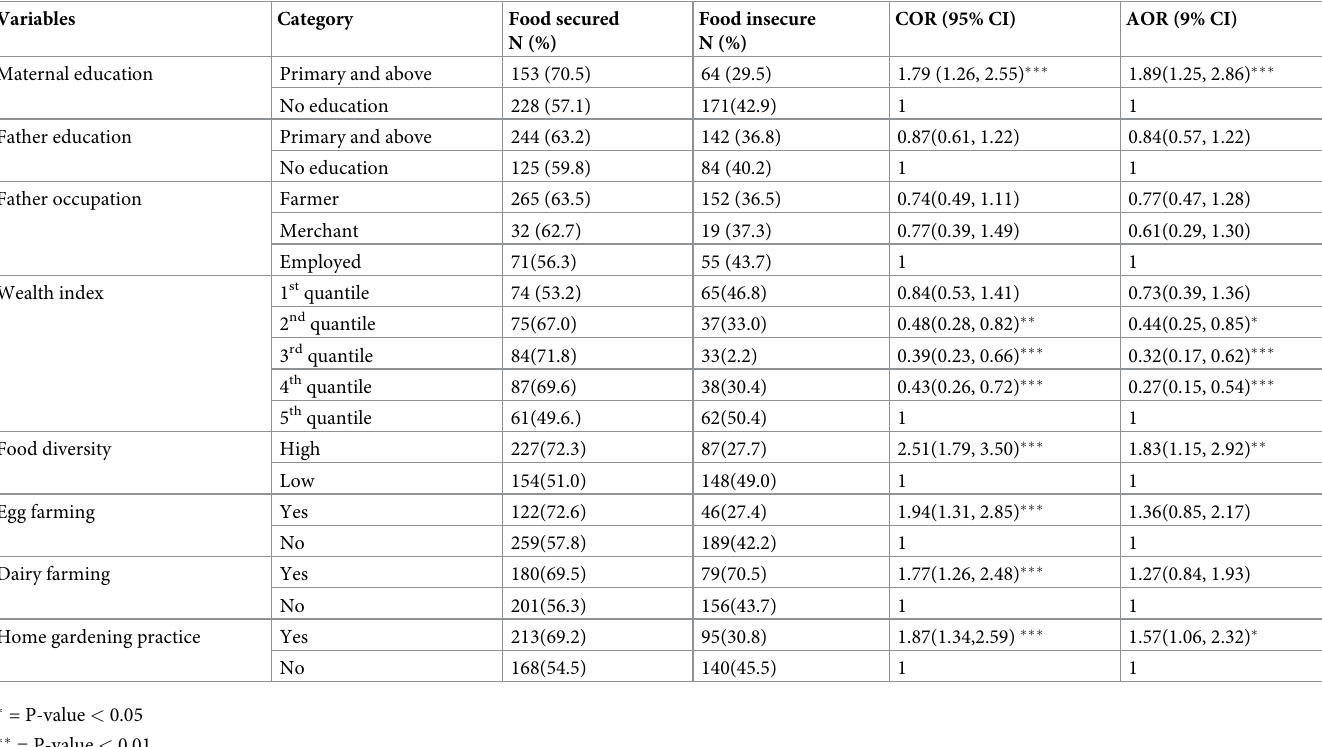
Table 3. Logistic regression analysis showed factors significantly associated with food security among home gardening and non-home gardening households in Zegie, Northwest Ethiopia, 2019.